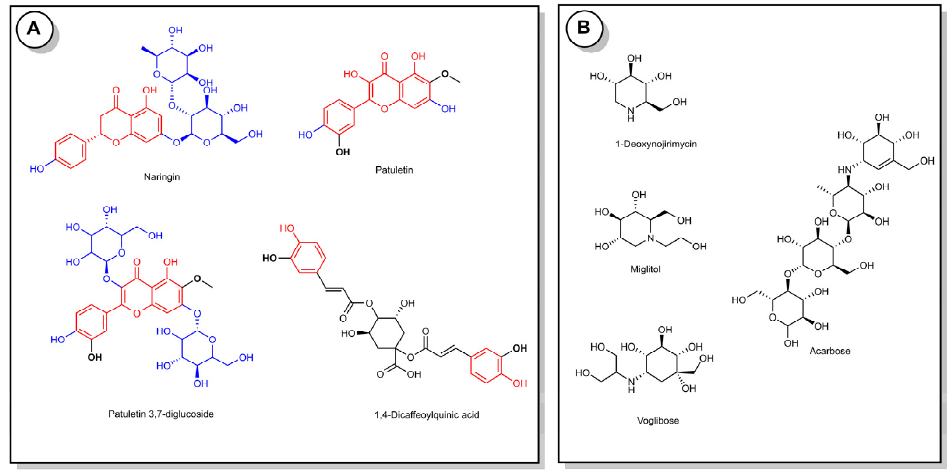
Figure 3. Chemical structures of identified compounds in the active sub-extract ( A ) and known α -glucosidase and α -amylase inhibitors ( B ).